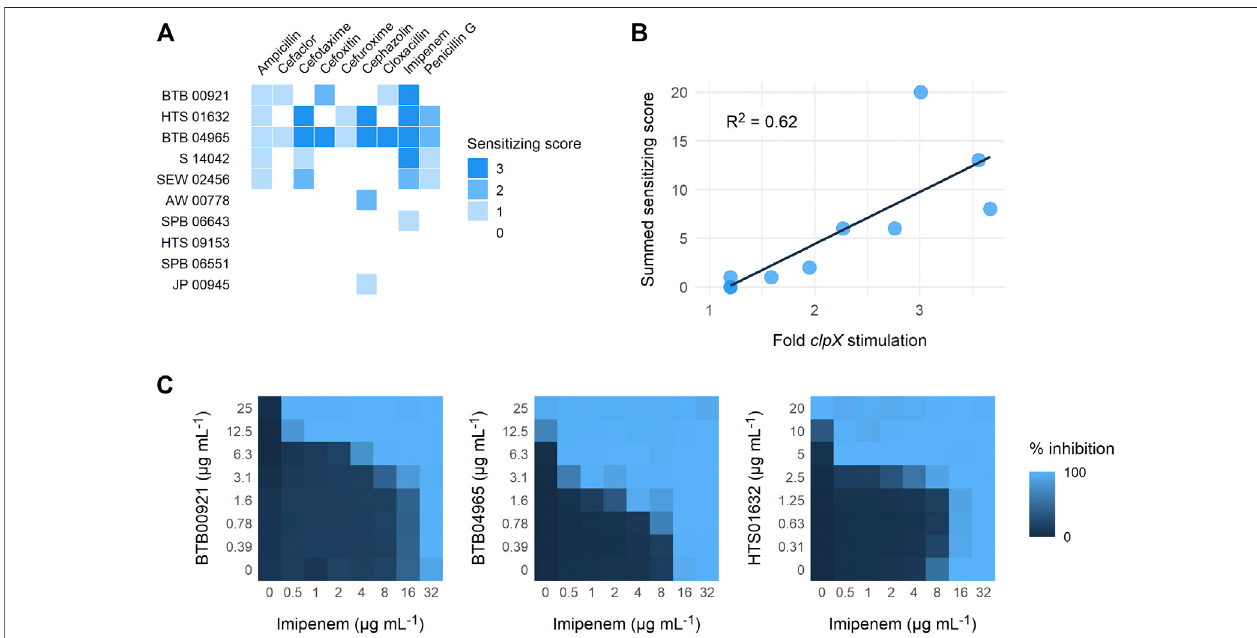
FIGURE 4 | Reversal of β -lactam resistance in MRSA strain COL. (A) The diameter of the clearing zones in the disc diffusion assay was measured and the ratio of the diameters ofthe inhibition zonesin thepresence and absenceofcompound wereused tocalculate asensitizingscoreforeach compound/ β -lactamcombinationas describedinthe Methods section.Thecompoundsarelistedaccordingtotheirabilitytostimulategrowthofthe clpX mutantfrombottomtotop. (B) Thescoresacrossall antibioticsareaddedtogiveatotalsynergyscoreforeach compound. Thescoreisplottedagainstthefoldchangeingrowthof clpX inthepresenceofcompound, together with a linear regression line ( R 2 (cid:2) 0.62) (C) Synergy between imipenem and the three compounds with highest sensitizing scores was evaluated by performing microdilution checkerboard analyses against the highly resistant MRSA strain, COL. The extent of inhibition is shown as a heat